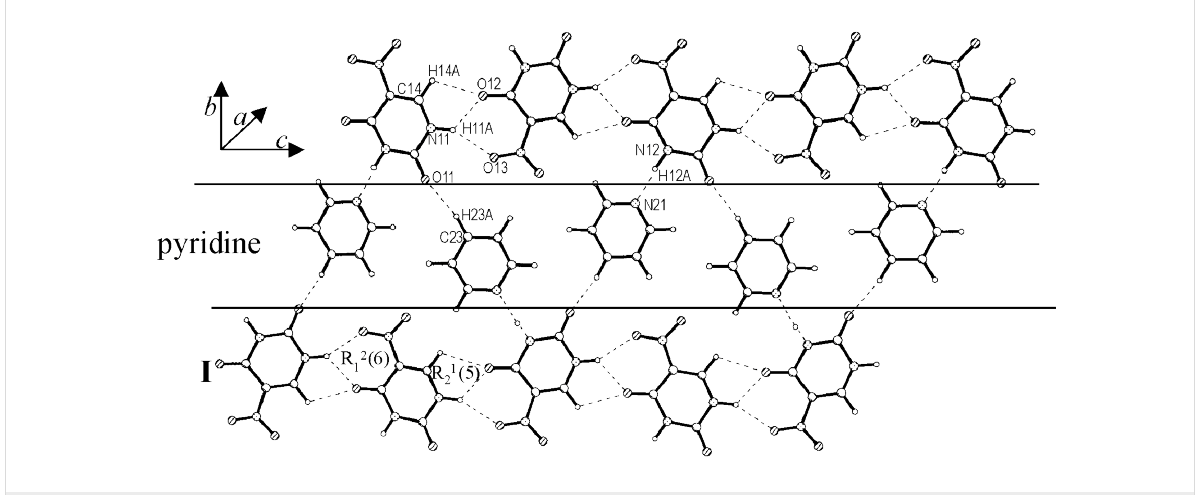
Figure 4: Cocrystal of I and pyridine: A molecular layer showing alternating rows of I and pyridine.